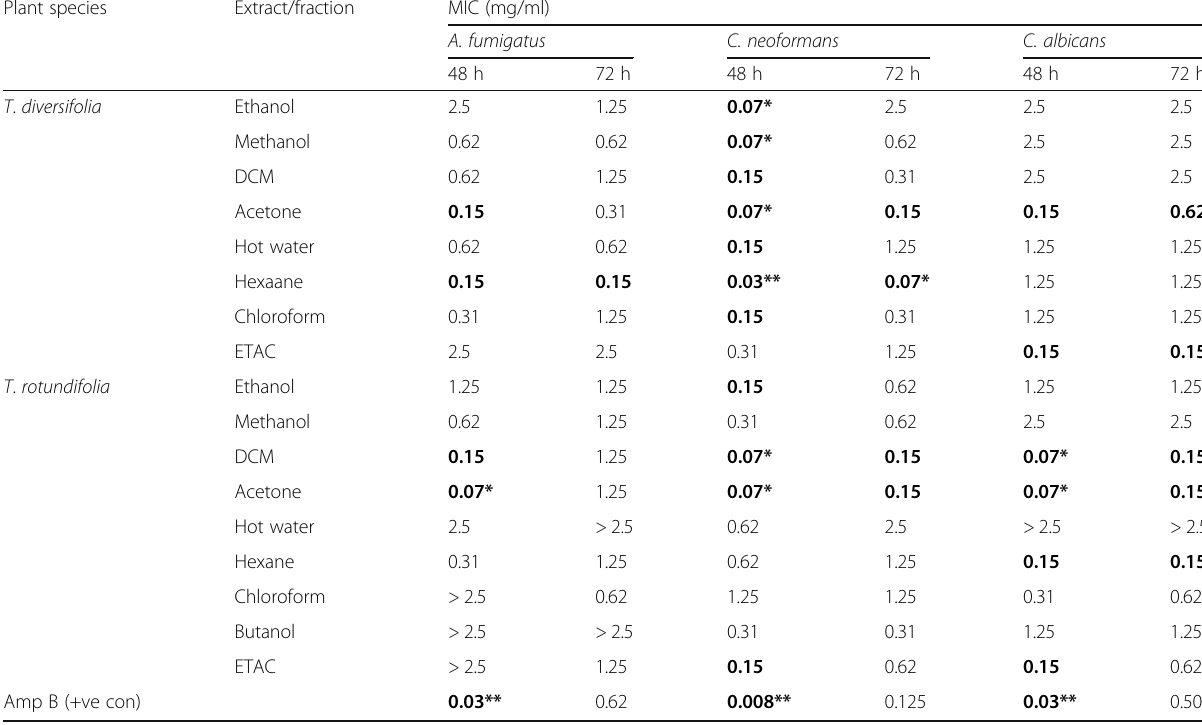
Table 3 Antifungal activity of solvent extracts and fractions of T . diversifolia and T . rotundifolia Plant species